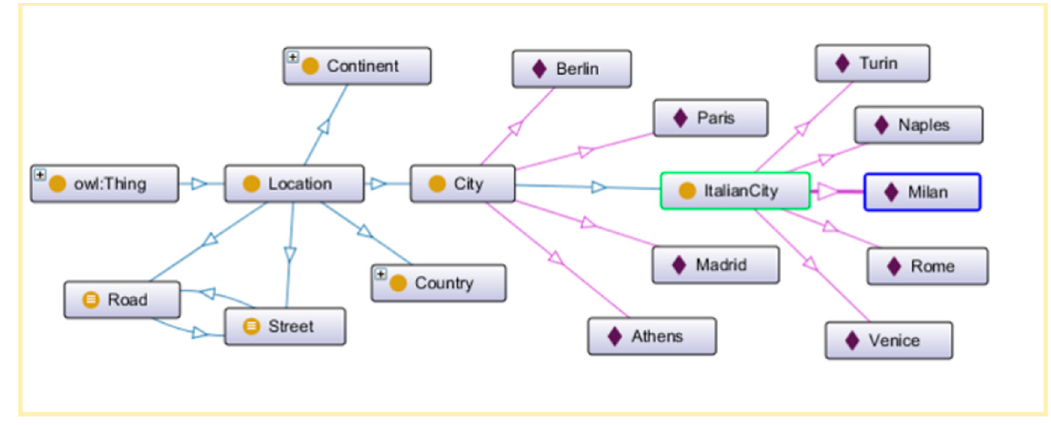
Figure 5. ItalianCity class hierarchy.